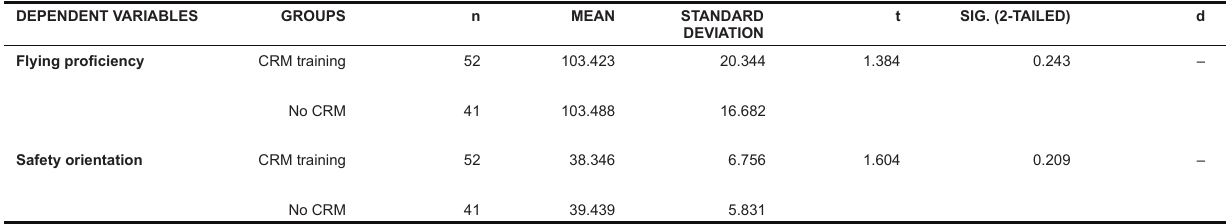
TABLE 4 T-test comparison of the mean scores of the perceptions held by instructors with and without CRM training regarding gender-related pilot